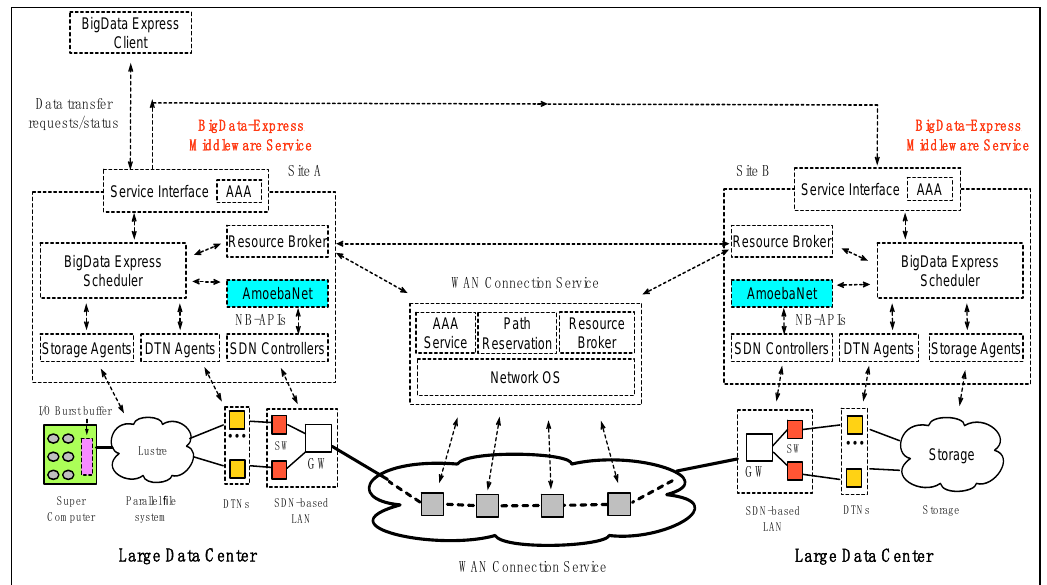
Figure 3. AmoebaNet service along with BigData express architecture.